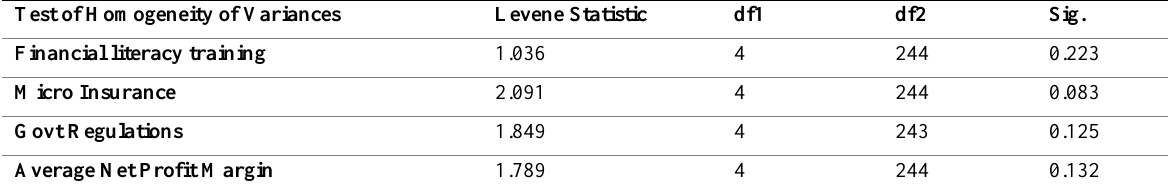
Table 4: Test of Homogeneity of